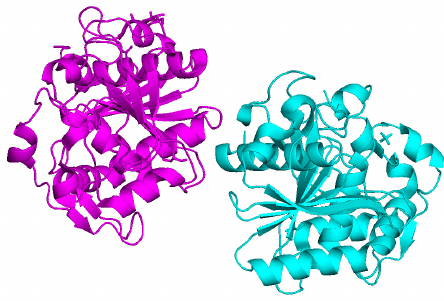
Figure 12. PDB deposited model of 5AP9. The rotational NCS axis is parallel to the